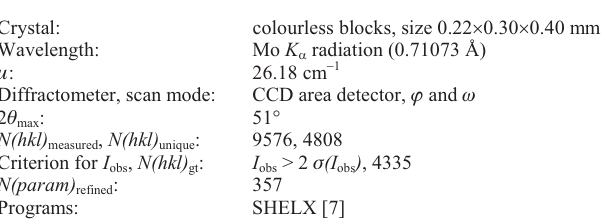
Table 1. Data collection and handling.